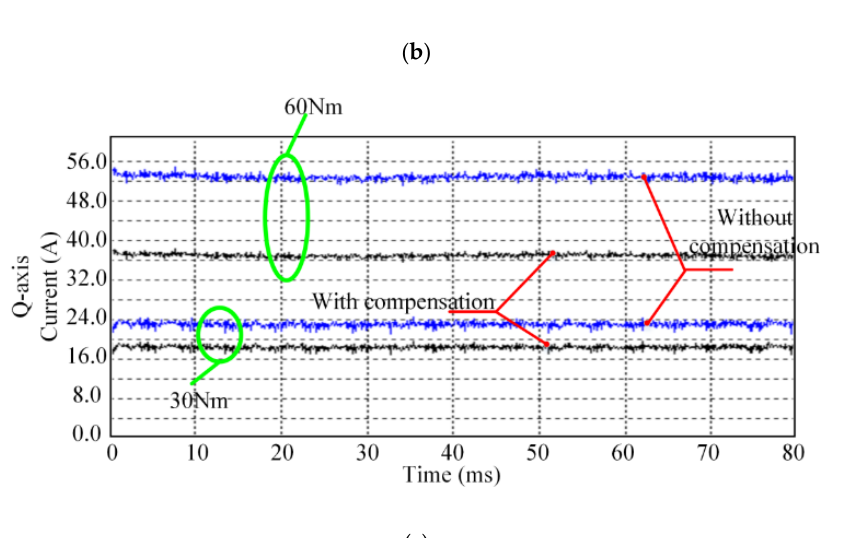
∗ = 0.5 R r ; ( b ) R ∗ = 0.8 R r ; r r